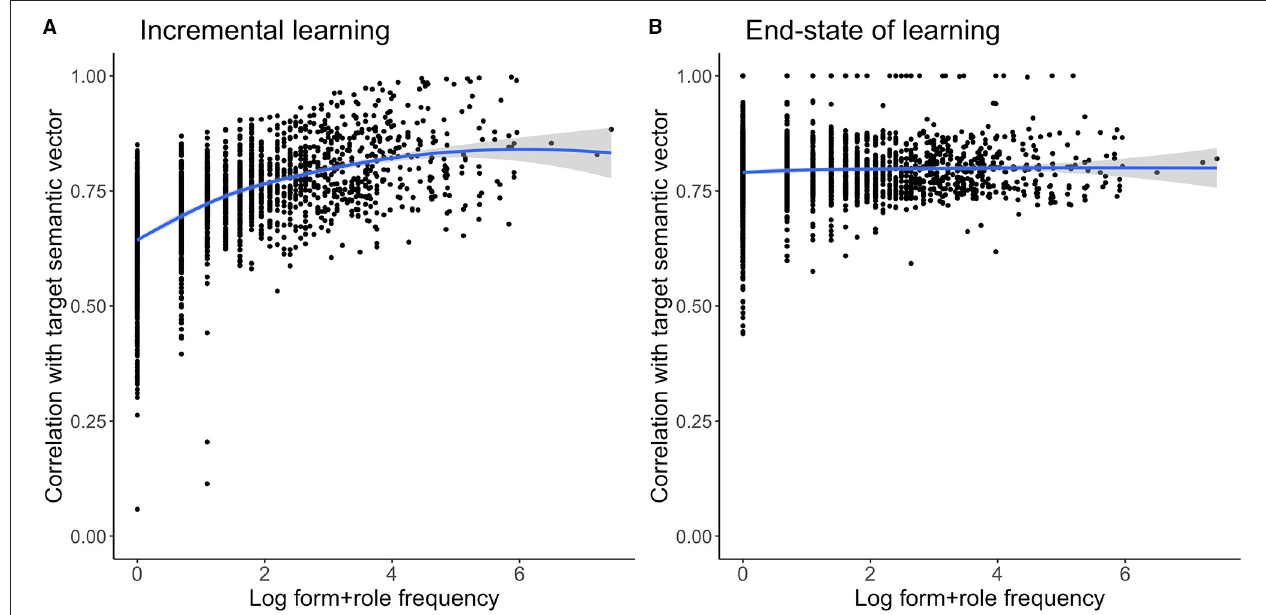
FIGURE 2 | Correlation between the simulated frequency and correlation of the predicted semantic vector with its target. Generally, the more frequent a word form is, the more accurate its semantic vector is predicted. The blue line indicates a loess smooth with a 0.95 confidence interval. (A) Incremental learning. (B) End-state of